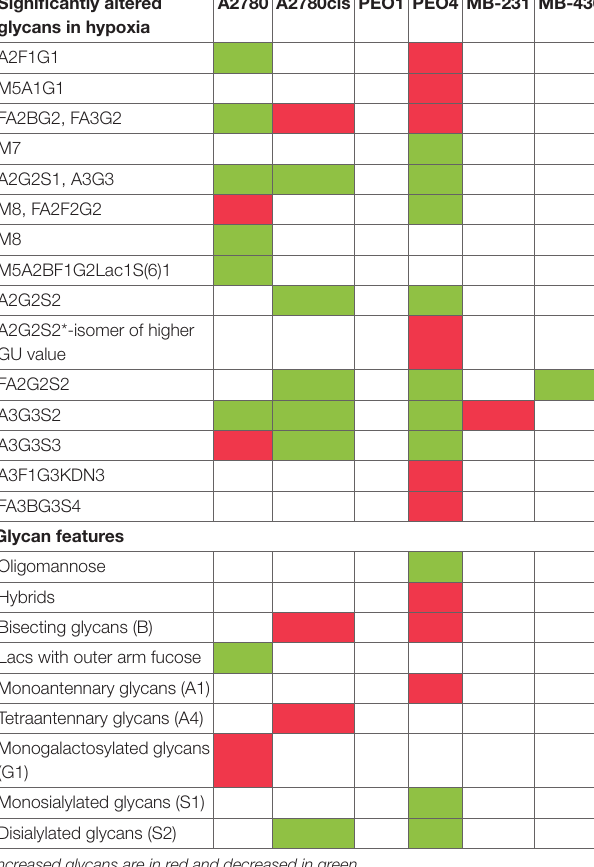
FIGURE 2 | linked mannose; B, bisecting GlcNAc linked β 1,4 to β 1,3 mannose; Gx, number of β 1,4 linked galactose on antenna; Fx, number of fucose linked α 1,3 to antenna GlcNAc; Sx, number of sialic acids linked to galactose; (C) Plotted peak areas of the N -glycans from secreted glycoproteins from ovarian and breast cancer cell lines. (D) Plotted features calculated from the peak areas of the N -glycans from secreted glycoproteins from ovarian and breast cancer cell lines [fold difference between hypoxia conditions and control normoxia (21% O 2 )]. Significant changes are starred: * P ≤ 0.05; ** P ≤ 0.01; *** P ≤ 0.001 (MANOVA). The histograms on the right side of the (C,D) are indicating increasing (in red) and decreasing (in blue) trends in GPs in hypoxia conditions comparing to normoxia.